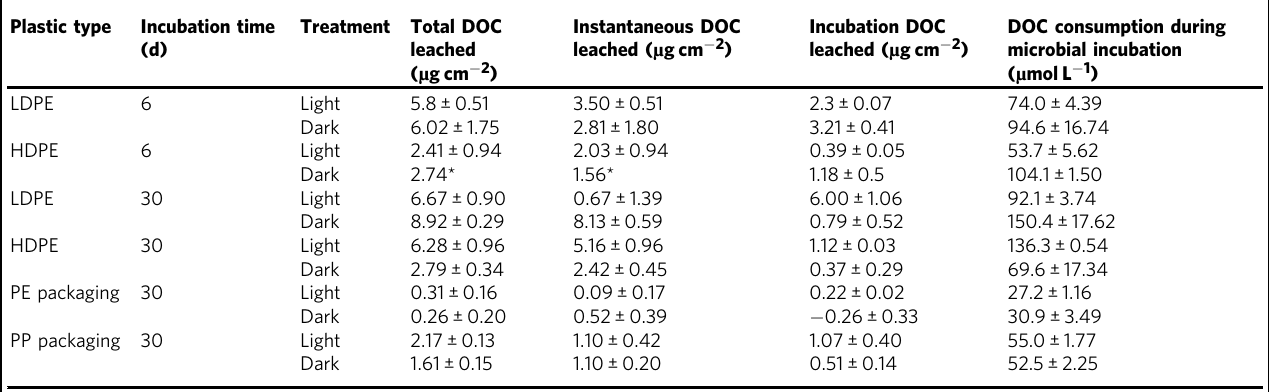
Table 1 DOC concentration leached from plastics during the light and dark incubations Plastic